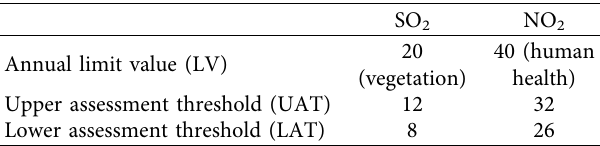
Table 1: Atmospheric air quality ( μ g/m 3 ) guidelines for selected air pollutants aiming to protect human health adopted by the Euro- pean Union Council Directive 2008/50/EB.